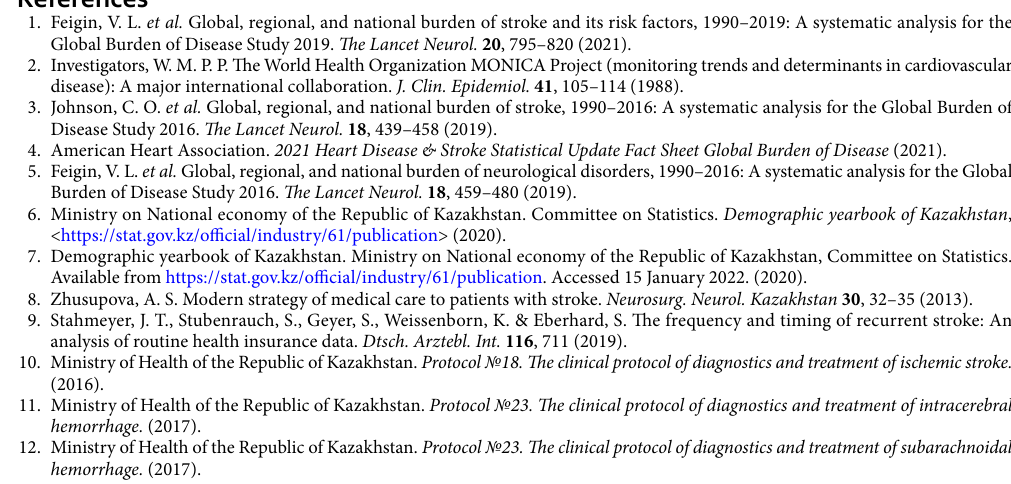
11. Ministry of Health of the Republic of Kazakhstan. Protocol №23. The clinical protocol of diagnostics and treatment of intracerebral hemorrhage. (2017). 12. Ministry of Health of the Republic of Kazakhstan. Protocol №23. The clinical protocol of diagnostics and treatment of subarachnoidal hemorrhage. (2017).